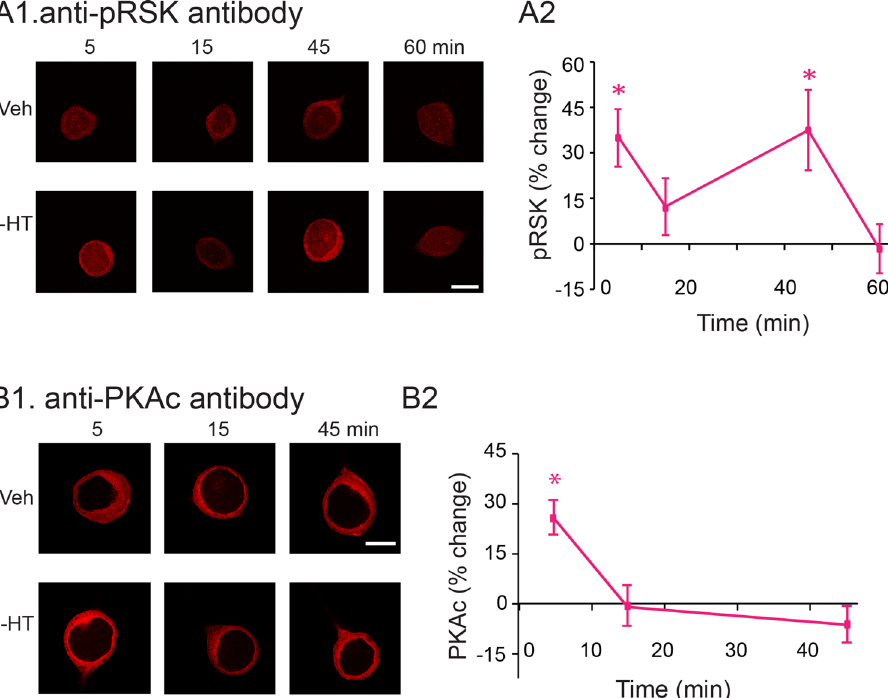
Figure 1. Dynamic regulation of pRSK ( A ) and PKA catalytic subunits (PKAc) ( B ) by a brief (5 min) pulse of 50 μM 5-HT. A1, Representative confocal images of pRSK immunofluorescence in SNs at different times post- onset of 5-HT. A2, Summary data. The percent change was calculated as the change of pRSK level after 5-HT compared to time-matched control levels. pRSK increased immediately after 5-HT (n = 8), returned to basal level at 15 min (n = 9), followed by a delayed increase at about 45 min (n = 13), and then a return to basal level at 60 min (n = 8). B1, Representative confocal images of PKAc at different times post-onset of 5-HT. B2, Summary data. The percent change was calculated as the change of PKAc level after 5-HT compared to time-matched control levels. PKAc increased immediately after 5-HT (n = 10), returned to basal level at 15 min (n = 7), and remained at basal level at 45 min (n = 8). Data are represented as mean ± SEM. All scale bars are 40 μm. *p <